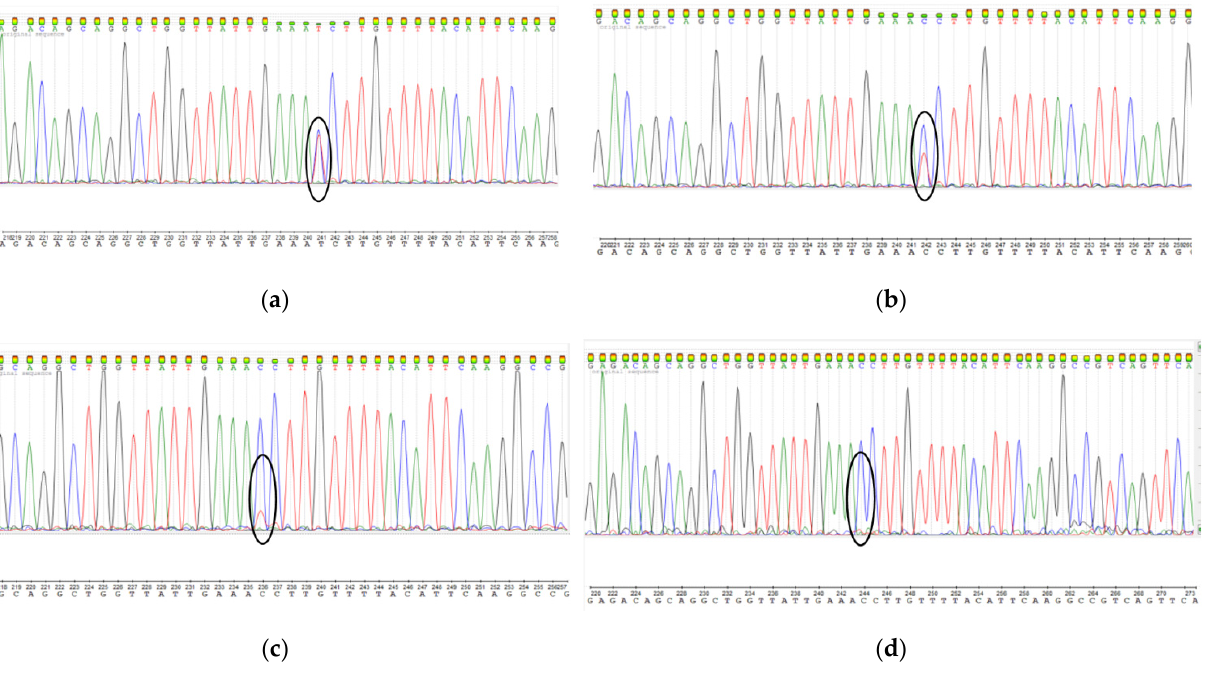
Figure 3. Detection of heterozygous mutation c.131G >A in MED12 gene in the same primary UL cell line at different passages: ( a ) p1; ( b ) p2; ( c ) p3; ( d ) control–healthy myometrium.